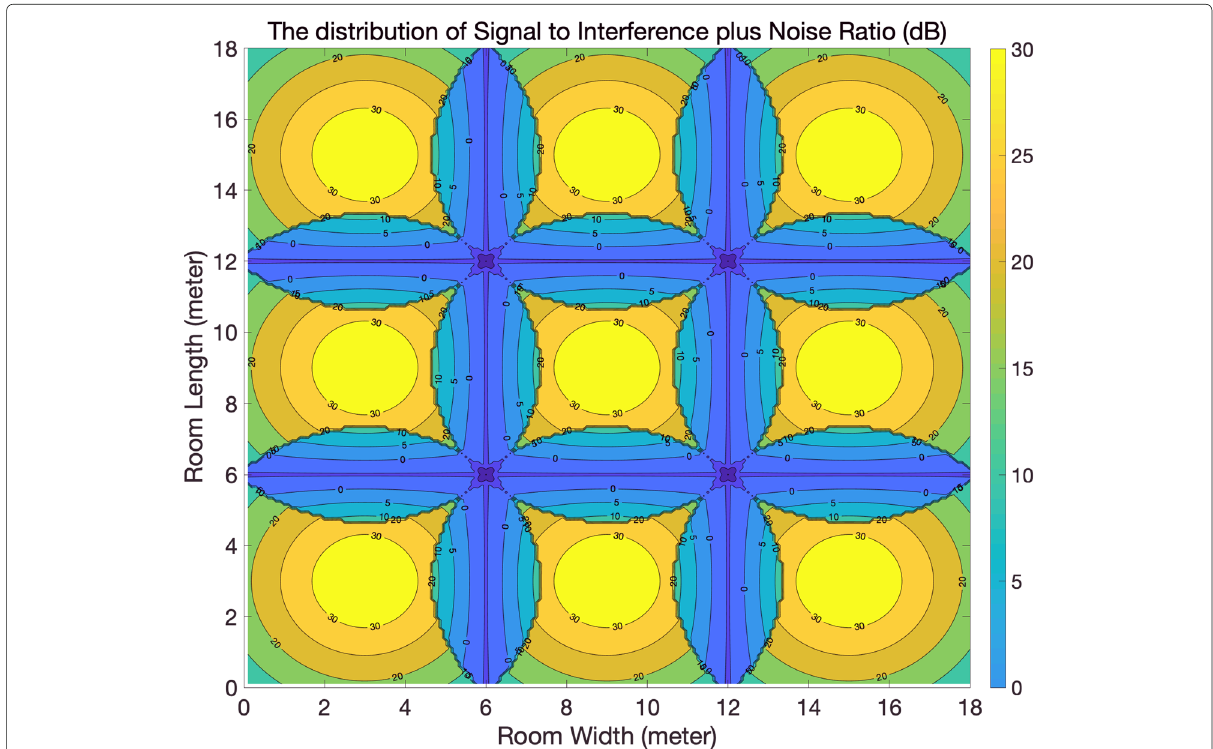
Fig. 4 SINR distribution in a multi-cell